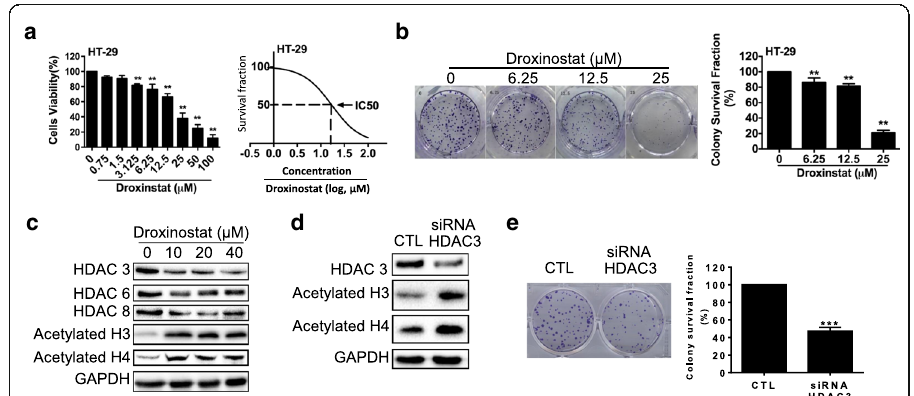
Fig. 1 Effects of droxinostat on cell viability in colon cancer cells. a – HT-29 cells were treated with the indicated concentrations of droxinostat. The viability of the cells was determined using the MTT assay (left panel). The IC 50 of droxinostat was calculated using GraphPad software (right panel). Each point represents the mean ± SD of three independent experiments. b – Droxinostat with the indicated concentrations was assessed using a clonogenic assay with 500 cells in each well. The significance was determined using one- way ANOVA. c – HT-29 cells were incubated with droxinostat for 48 h. The indicated protein was detected via western blot. d – Knockdown HDAC3 by siRNA in HT-29 cells. e – A clonogenic assay using HDAC3 knockdown cells with 250 cells in each well. ** p < 0.01 vs vehicle or